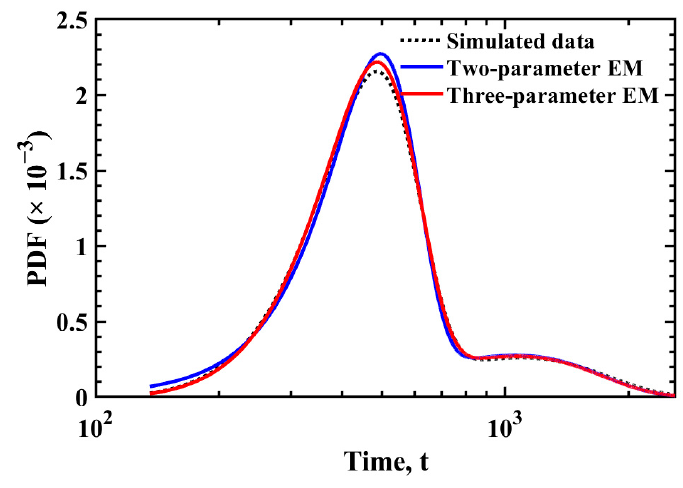
Figure 4. Simulation of fitted probability density functions of failure times.